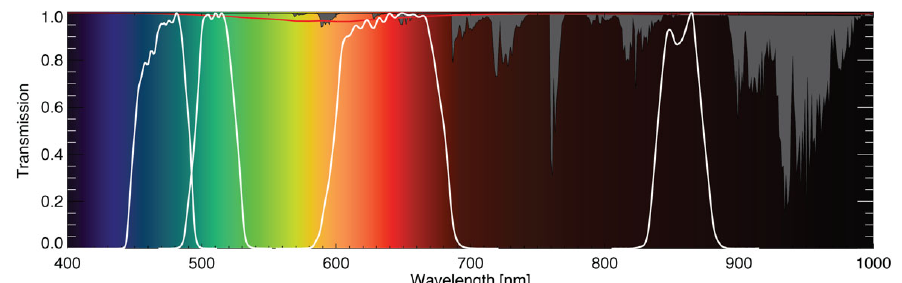
Figure 1. Himawari-8 spectral response functions of the visible and infrared bands (solid white lines) with the transmission of the atmospheric gases (grey filled line) and the transmission by ozone (red solid line) between 400 and 1000 nm.